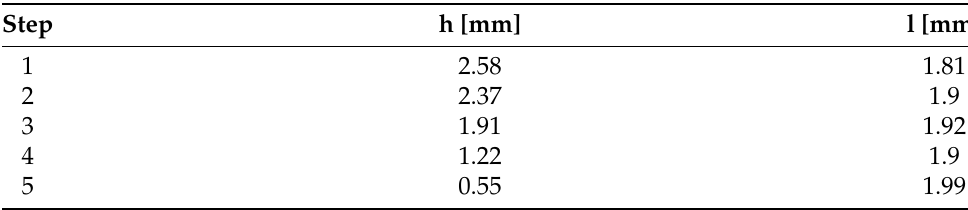
Table 1. Geometrical size of the Chebyshev impedance